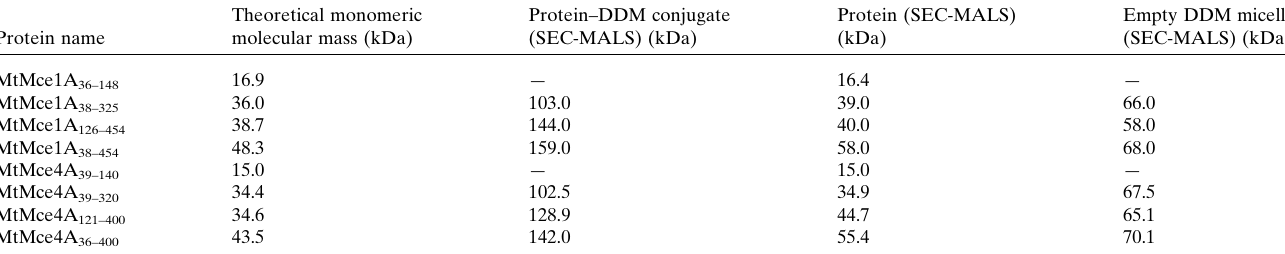
Table 2 Molecular masses of MtMce1A and MtMce4A domains as calculated from SEC-MALS. Theoretical monomeric Protein name molecular mass (kDa)